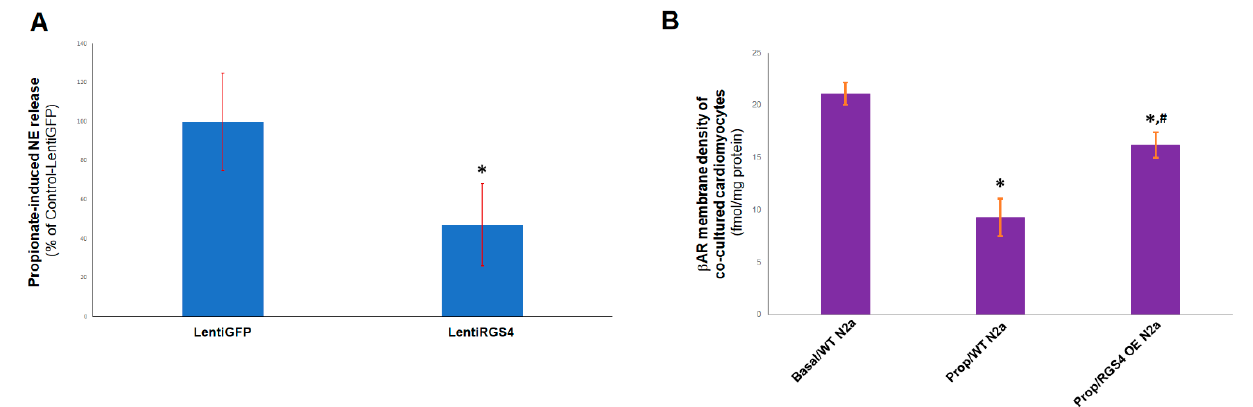
Figure 4. RGS4 and neuronal FFAR3-mediated NE release. ( A ) Levels of NE released into the culture medium from the control (infected with a lentivirus encoding for green fluorescent protein, LentiGFP) or RGS4-overexpressing (infected with a lentivirus encoding for full length RGS4, LentiRGS4) differentiated Neuro-2A (N2a) cells in response to 1 mM of propionate stimulation. No statistically significant difference in NE release was observed between the two cell clones under basal conditions, i.e., without propionate stimulation (data not shown). * , p < 0.05; n = 5 independent measurements per condition per cell clone. ( B ) β AR density (B max ) in plasma membranes isolated from H9c2 cardiomyocytes at 24 hrs post-stimulation with 1 mM propionate (Prop) or vehicle (Basal) of co-cultured control, wild-type (WT) or RGS4-overexpressing (RGS4 OE) N2a cells. The β AR density measured with vehicle-treated RGS4-overexpressing N2a cells (Basal/RGS4 OE N2a) was similar to the one calculated with Basal/WT N2a cells (not shown). * , p < 0.05, vs. Basal/WT N2a; # , p < 0.05 vs. Prop/WT N2a; n = 3 independent determinations per condition per cell clone.